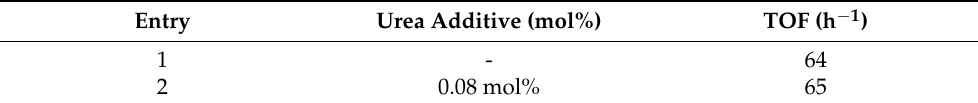
Figure 7. Urea additive study. Table 2. Urea additive study.